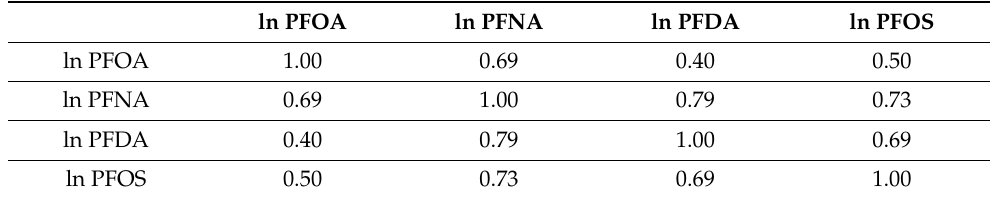
Table 3. Correlation between PFAS variables